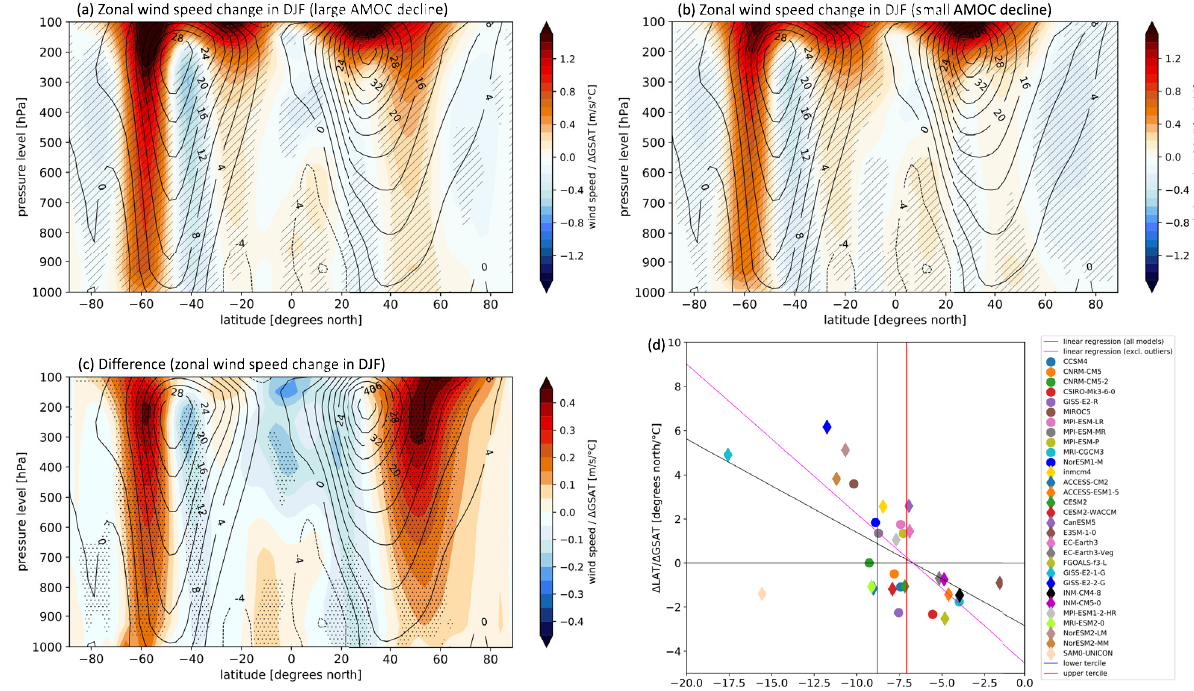
Fig. 4 Winter wind speed change associated with AMOC. Panels a , b show the normalized zonal mean wind speed change in DJF in the abrupt-4xCO 2 with respect to the preindustrial control for a the average of the large AMOC decline group and b the average of the small AMOC decline group. Panel c is their difference (a minus b). For each model, the zonal mean wind speed change is divided by the respective Δ GSAT, hence units are of m/s per degree of global warming. In panels a – c , superimposed contours show the climatological zonal mean wind speed in DJF computed from all models. Panel d shows the change in the latitude of the maximum westerly wind speed at 250 hPa in the northern hemisphere ( Δ LAT) divided by Δ GSAT, against AMOC change ( Δ AMOC). Circles represent CMIP5 models, while diamonds represent CMIP6 models. The dashed black line is the linear regression including all models ( y ¼ (cid:2) 0 : 42 x (cid:2) 2 : 84 with R 2 : 0.33), while the dashed magenta line is the linear regression excluding the models GISS-E2-1-G and SAM0-UNICON ( y ¼ (cid:2) 0 : 68 x (cid:2) 4 : 54 with R 2 : 0.48). The blue and red vertical lines represent the lower and upper terciles of the Δ AMOC distribution. Models to the left of the blue line belong to the large AMOC decline group, while models to the right of the red line belong to the small AMOC decline